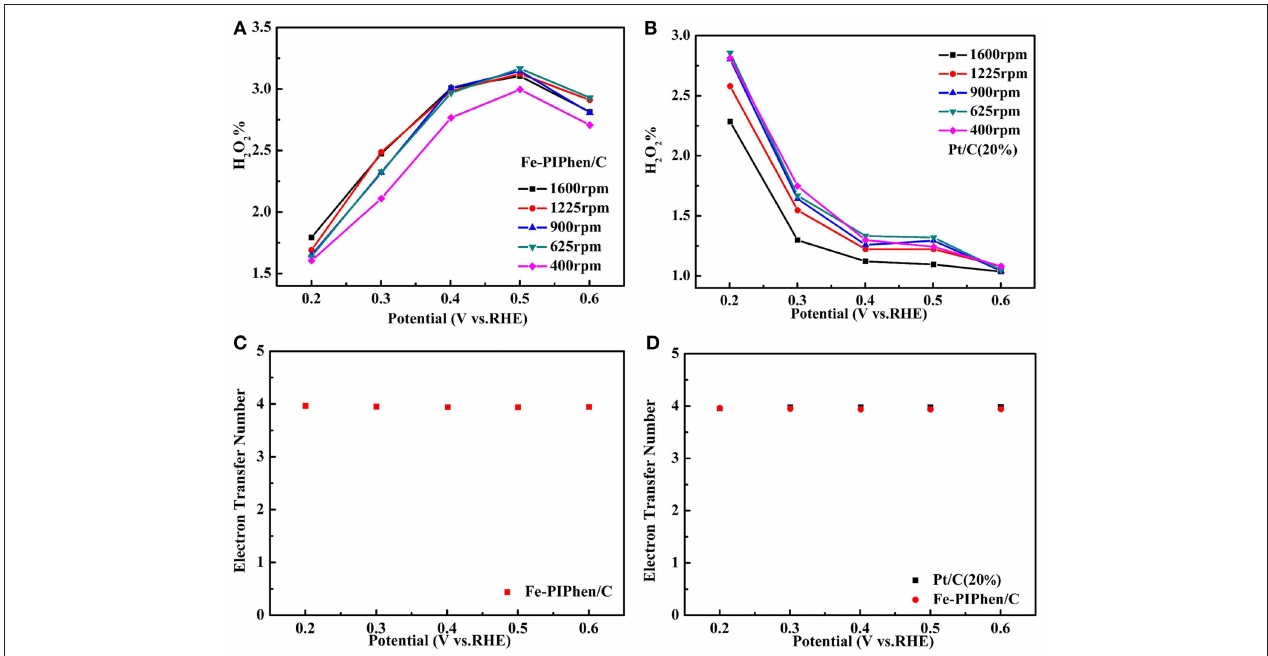
FIGURE 10 | Hydrogen peroxide yield of Fe-PIPhen/C (A) and Pt/C(20% content) (B) at various rotating rate, respectively, the ETN for Fe-PIPhen/Cat different potentials (1600 rpm) (C) , the ETN for Fe-PIPhen/C and Pt/C(20% content) at different potentials (1600 rpm) (D) .